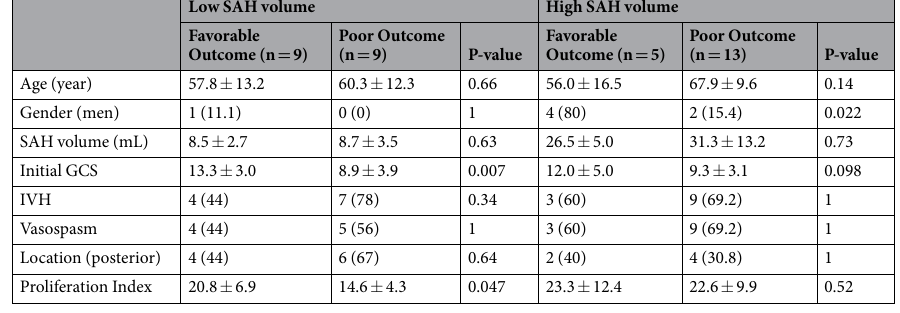
Table 1. Comparison between patients with favorable and poor outcome by SAH volume. Values are mean ± standard deviation except gender, IVH, vasospasm, and location; number (percentage). SAH indicates subarachnoid hemorrhage; GCS, Glasgow coma scale; IVH, intraventricular hemorrhage. The low or high SAH volume is defined as the SAH volume at subarachnoid cistern less or more than 15 ml, respectively. The posterior location of aneurysm includes vertebral or basilar arteries, posterior cerebral artery, posterior communicating artery, and posterior inferior cerebellar artery. Favorable outcome, mRS = 0, 1, or 2.